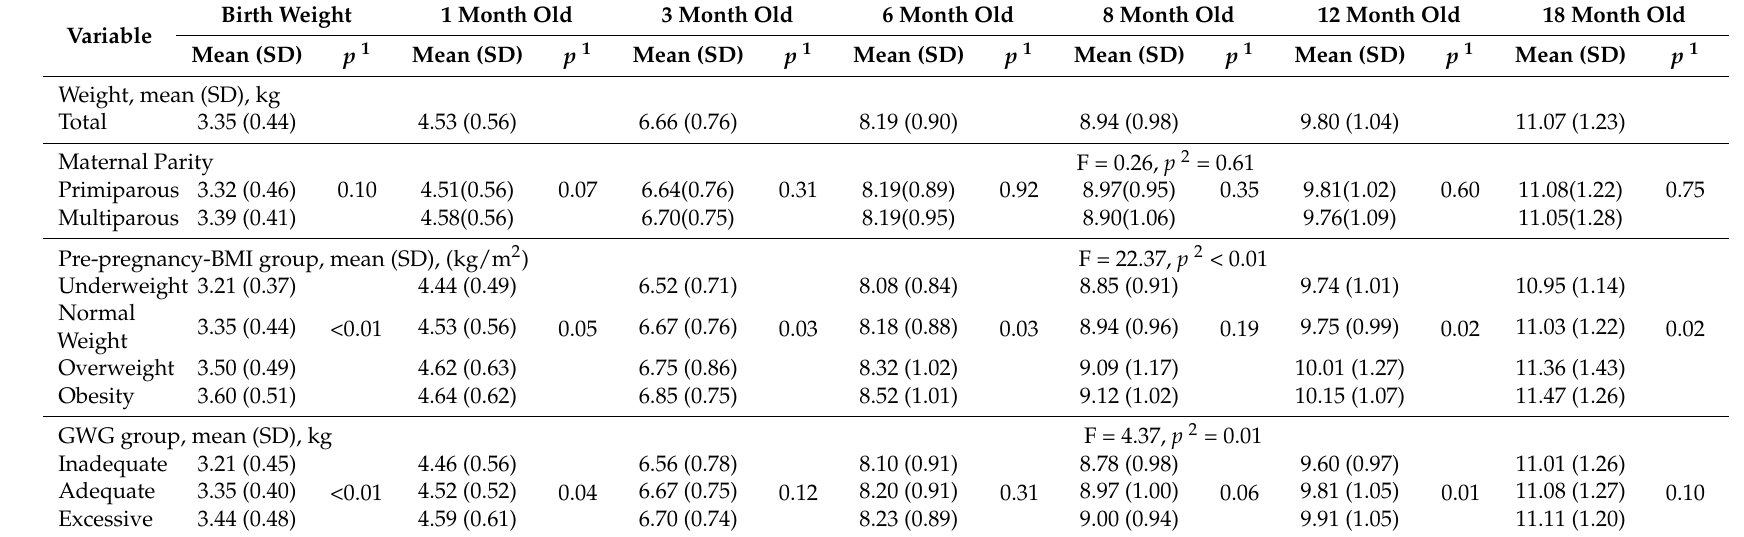
Table 2. Levels of child weight for different pre-pregnancy BMI groups and GWG